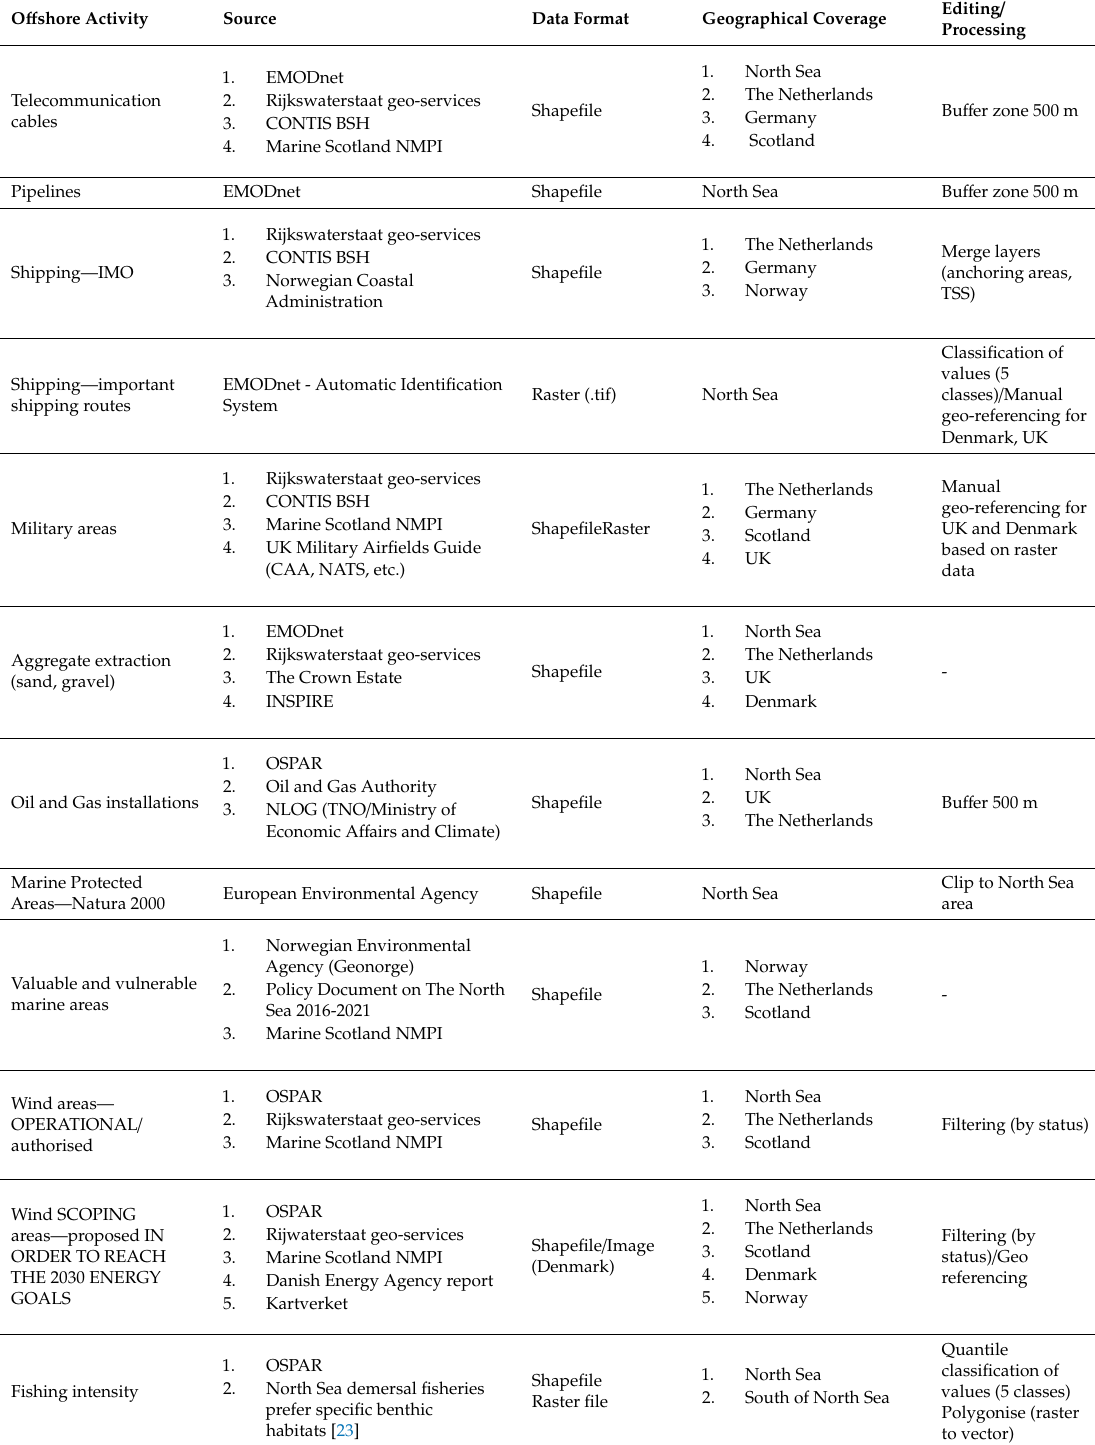
Table 1. Geographic Information System (GIS) repository for selected o ff shore